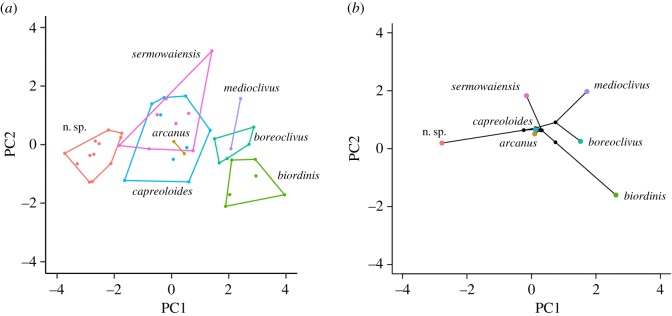
(a) PCA plots of size-corrected data for seven species of Cyrtodactylus from Melanesia. (b) Phylomorphospace plots of species means for PCA analyses superimposed on phylogenetic relationships for seven species of Cyrtodactylus from Melanesia.